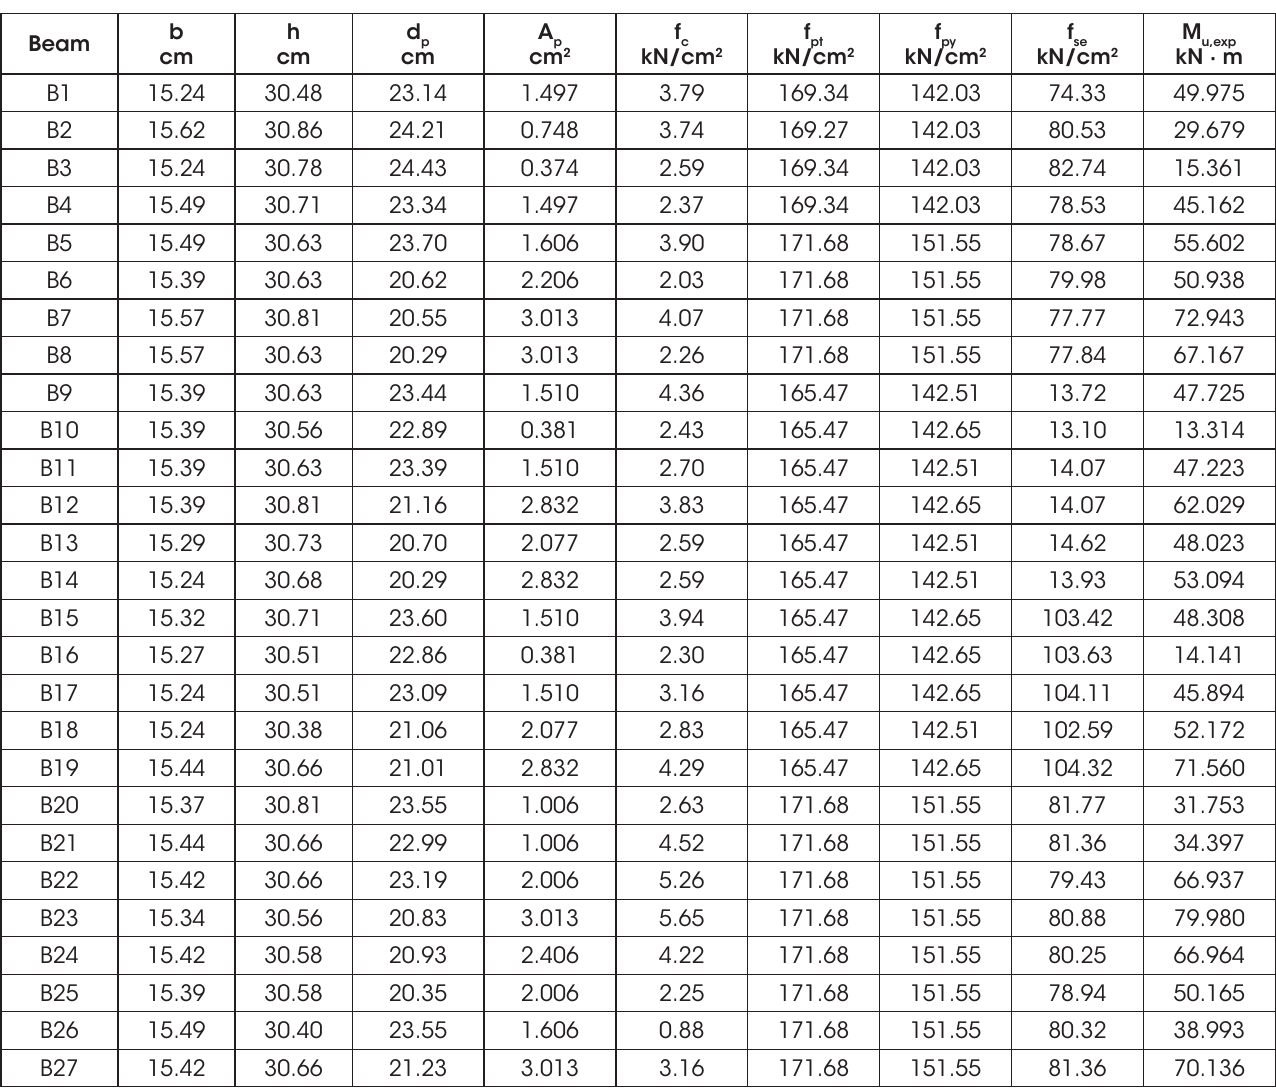
Data from the beams tested by BILLET